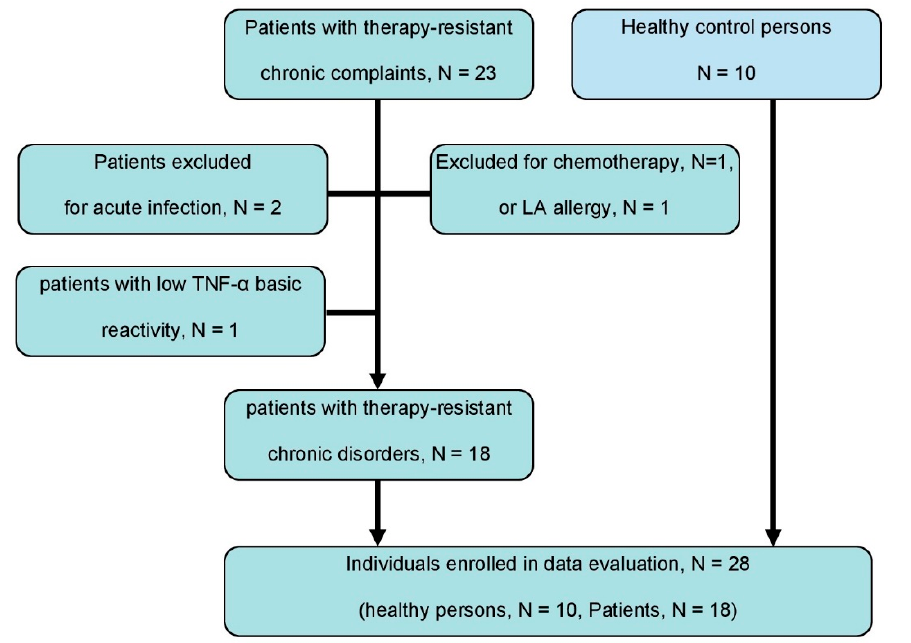
Figure 2. Flow chart of patient and control person selection according to the STARD criteria [42]. Eligible patients are consecutively recruited patients with therapy-resistant chronic pain or inflammation ( ≥ 6 months of complaints).